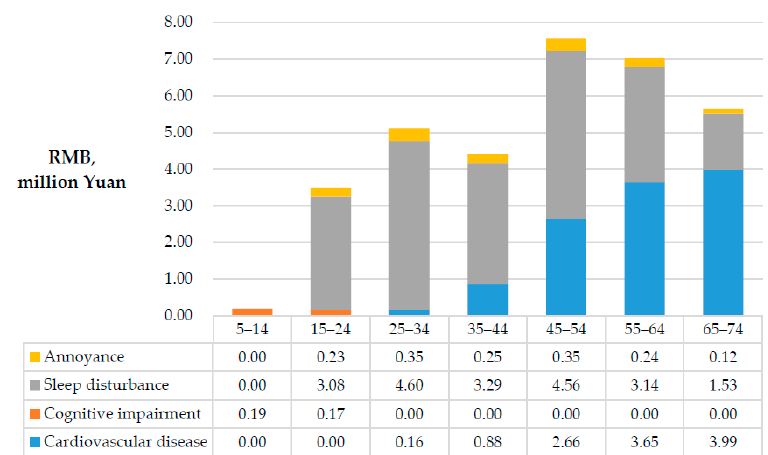
Figure 6. Environmental impacts on age groups.